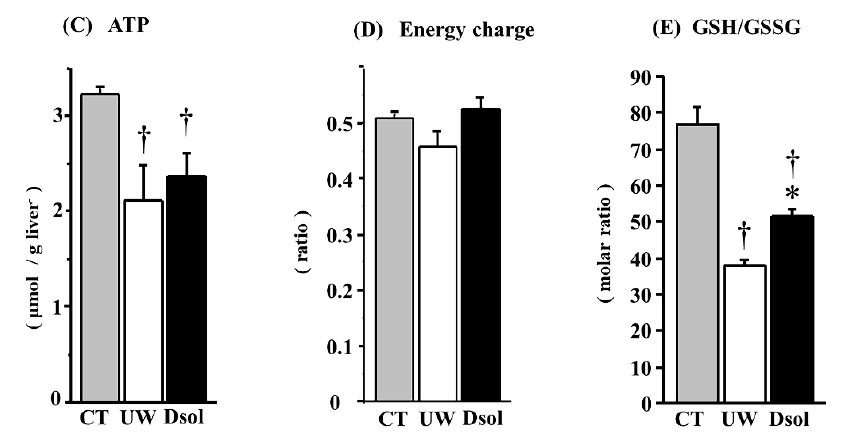
Figure 4. Dsol maintains hepatic functions. Oxygen consumption rate (OCR) at the end of reperfusion and total bile production during 90 min of reperfusion were determined as indices of liver function. In the CT group, OCR ( A ) and bile production ( B ) were the highest. In the UW group, they were the lowest ( † ), whereas the decreases were significantly suppressed in the Dsol group (*, † ). In the CT group, ATP at the end of reperfusion ( C ) was the highest. It was significantly reduced ( † ) in the both UW and Dsol groups. ATP content in the Dsol group was slightly higher than that of the UW group (statistically not significant). Energy charge at the end of reperfusion was the lowest in the UW group, whereas it was almost equivalent in the CT and Dsol groups ( D ). In the CT group, reduced glutathione (GSH)/oxidized glutathione (GSSG) ( E ) was the highest. In the UW group, it was the lowest (†), whereas the decreases were significantly suppressed in the Dsol group (*, †). Data were expressed as the means ± SD ( n = 6). *†A p -Value less than 0.05 was considered signi fi cant: *: UW versus Dsol, †: versus CT.